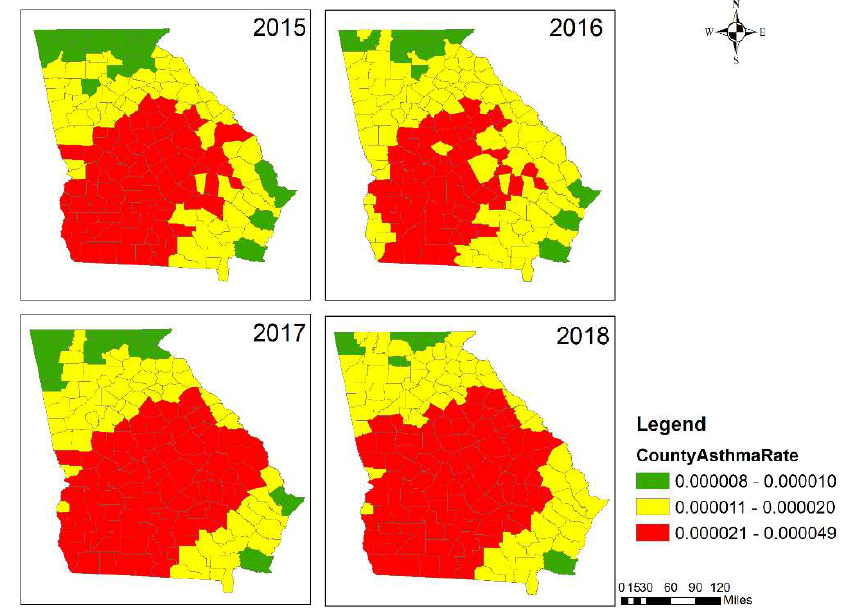
Figure 9. Estimated asthma-related ER visit rates (per person) due to prescribed burning by county in Georgia from 2015 to 2018 for the first four months of the